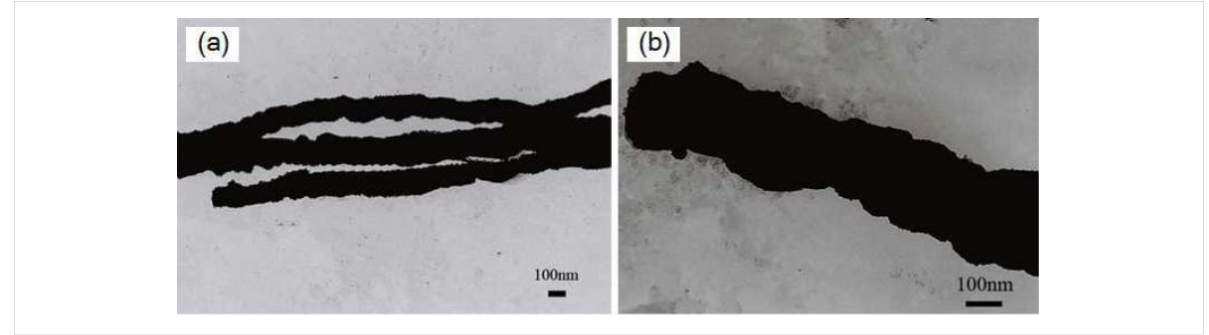
Figure 3: TEM images of prepared Ni nanowires (a) and Ni/Cu nanowires (b).